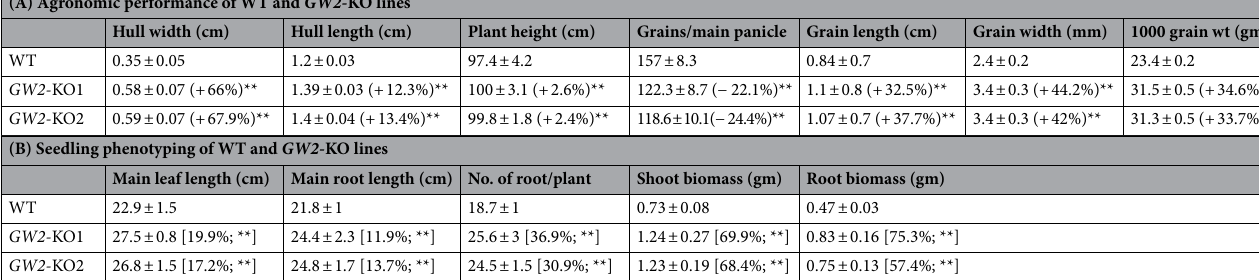
Table 1. The hull length and width, grain length and width, plant height, 1000 grain weight increased significantly p ≤ 0.01 (**) except grain number per min panicle which is significantly decreased compared